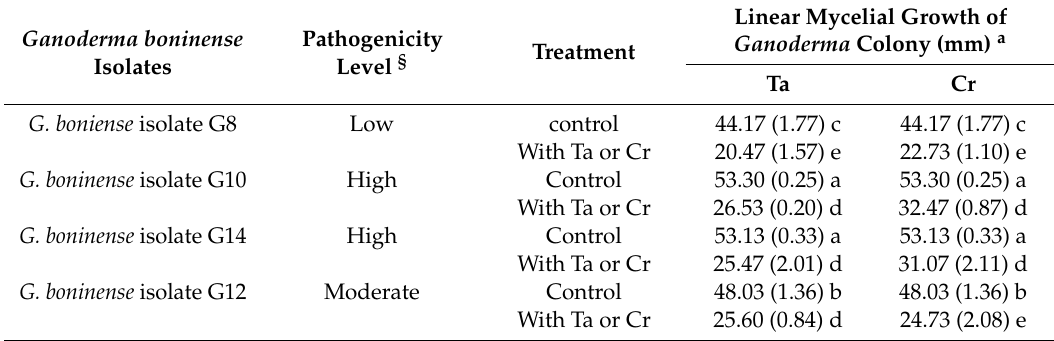
Table 2. Reduction of linear mycelial growth of four Ganoderma boninense isolates by